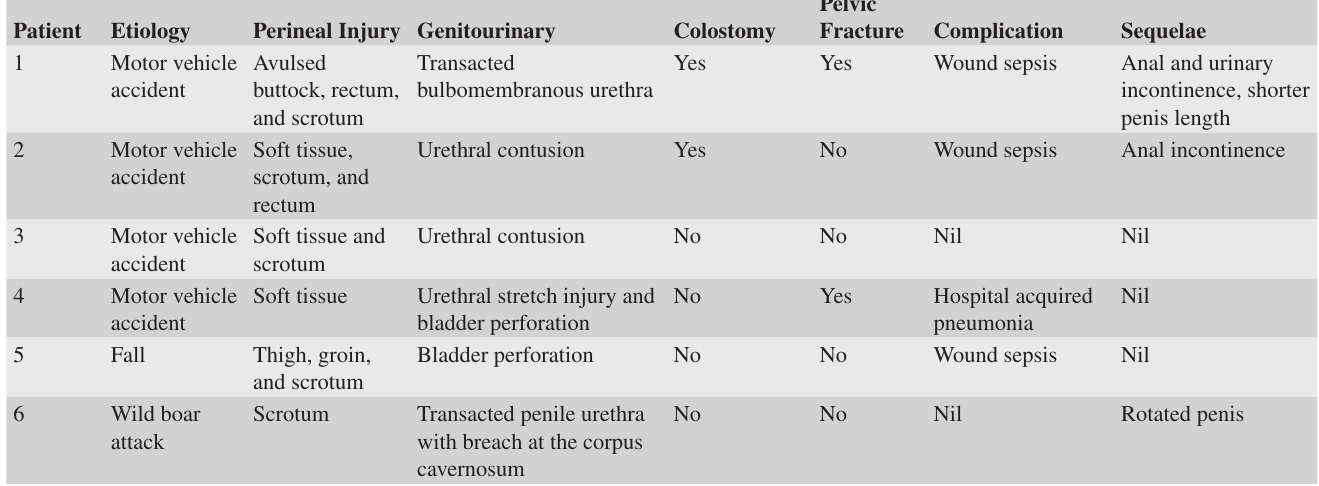
Table 1. Degloving Perineal Injuries in 6 Cases